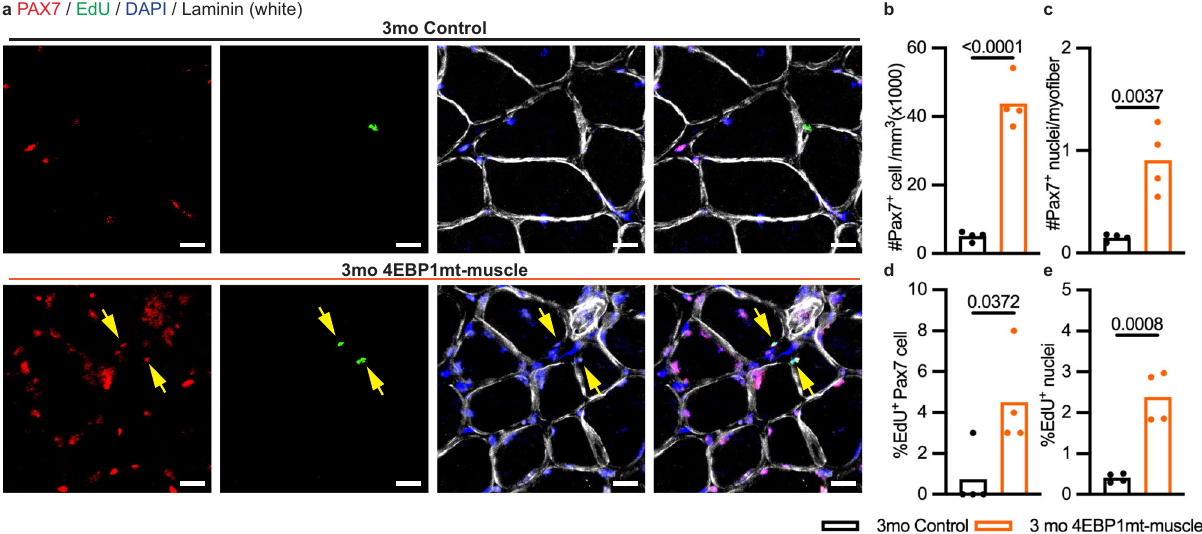
Fig. 6 | 4EBP1 activation increases satellite cell number and activity. a Representative confocal images of PAX7 (red), EdU (green), DAPI (blue) and Laminin (white) staining of cross-sections of the gastrocnemius muscle from 3- month-old male mice (3mo Control and 4EBP1mt-muscle, n =4 per group). Solid Arrows=EdU and PAX7 double-positive satellite cells. Scale bar=20 μ m. b , c Quanti fi cationofthenumberofPax7-positivenucleinormalizedto( b )areaand